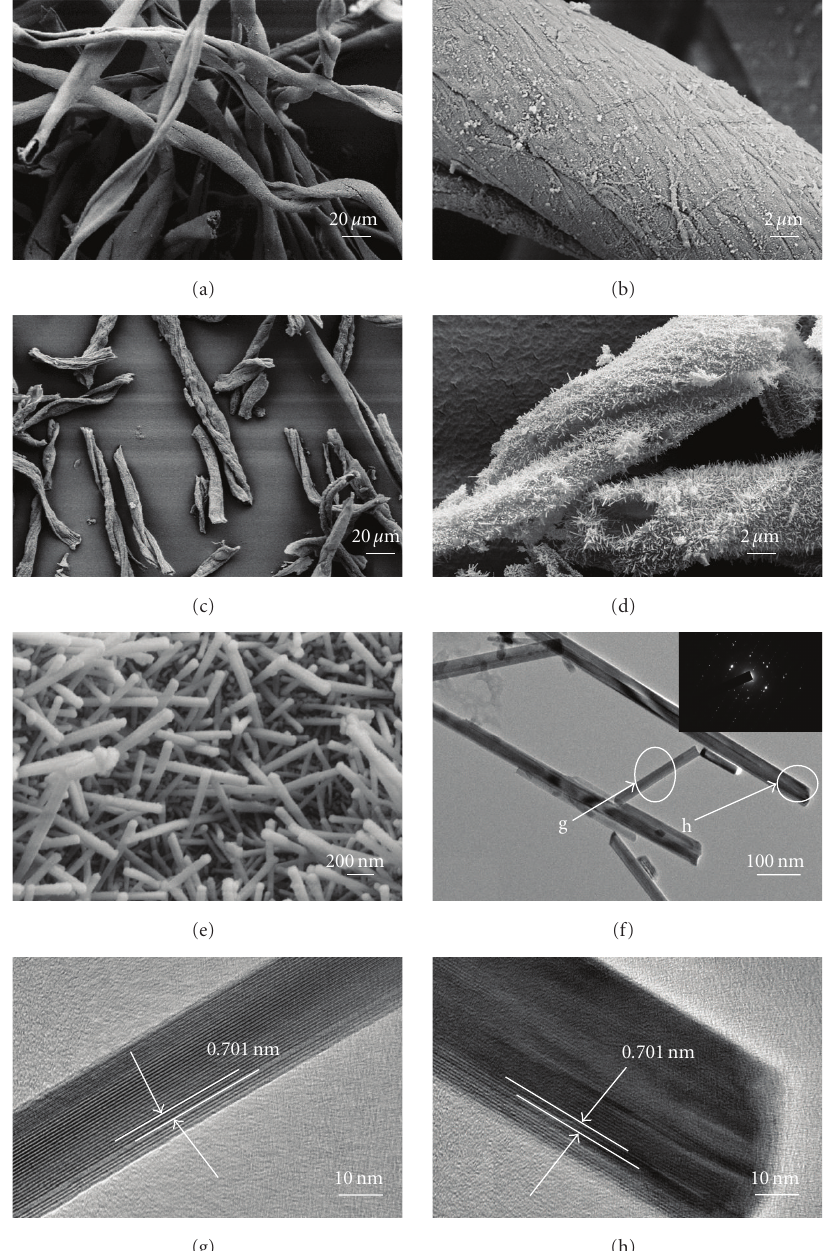
Figure 2: SEM images of the precursor/cotton of sample 1 (a), (b) and sample 1 (c)–(e) and TEM images of sample 1 (f)–(h); the inset in (f) is SAED pattern; the rectangle areas in panel (f) correspond to panels (g) and